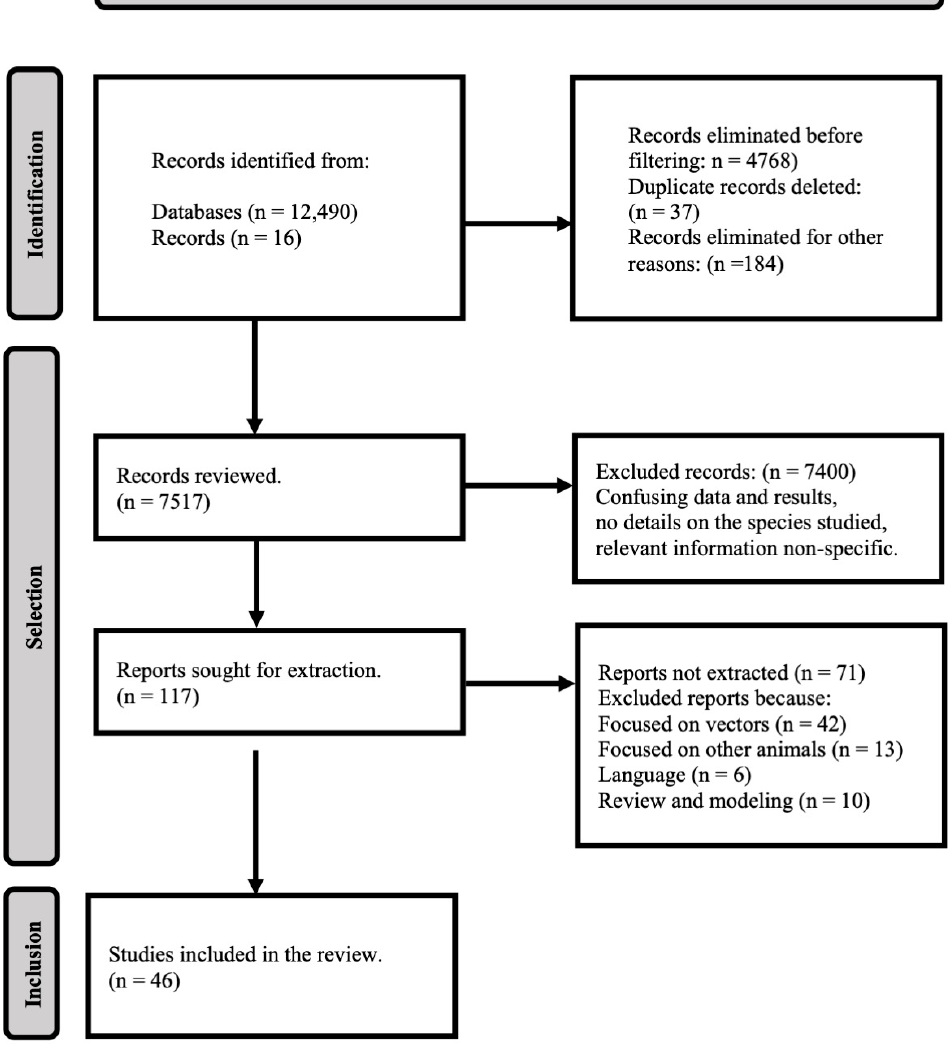
Figure 1. Flow chart modified from (PRISMA 2009) describing the literature search and study selec- tion.